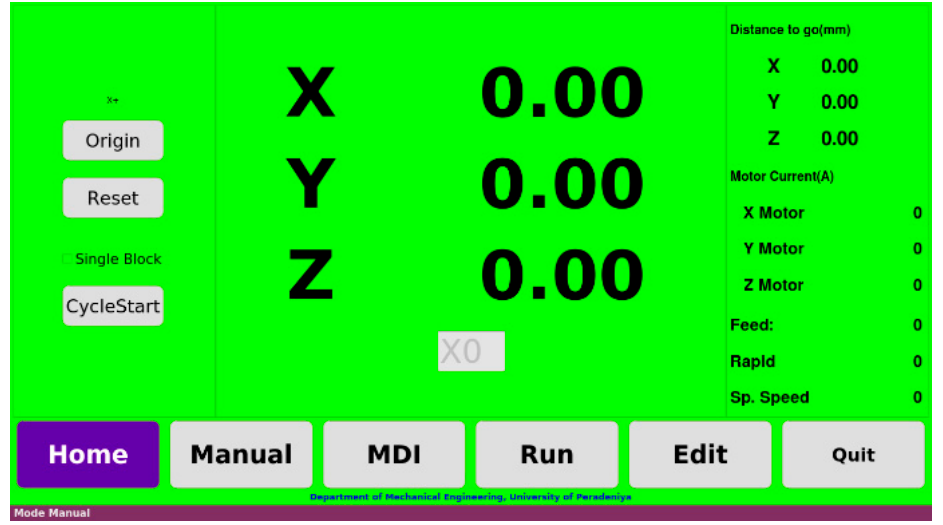
Figure 10. HMI of the CNC machine.